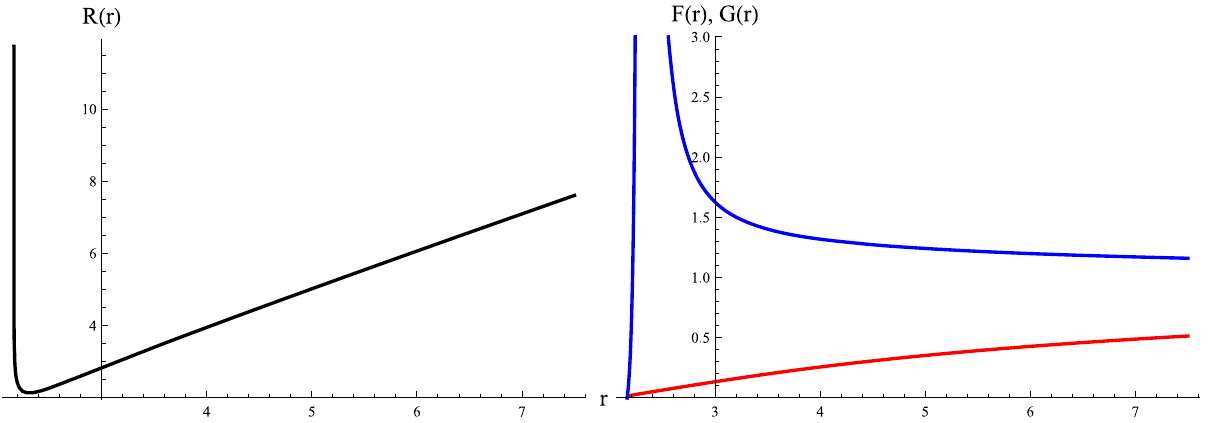
Fig. 1 Typical behaviors of R (left), F (right, red), and G (right, blue), where we have chosen a = 3, b = 2, and h = 1. Even though the dilaton field is singular at the center, as long as a > b , the center is null. One can see that R is bounced to infinity and hence the center is a kind of infinity